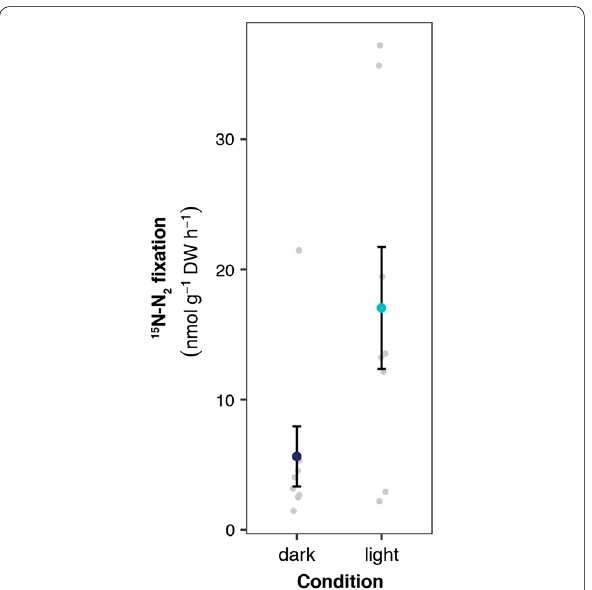
Fig. 2 Plot showing the average N 2 fixation rates measured as 15 N-N 2 incorporation from incubations performed in the field either in the dark (dark blue) or in the light (light blue). Error bars indicate SEM and light grey dots show raw